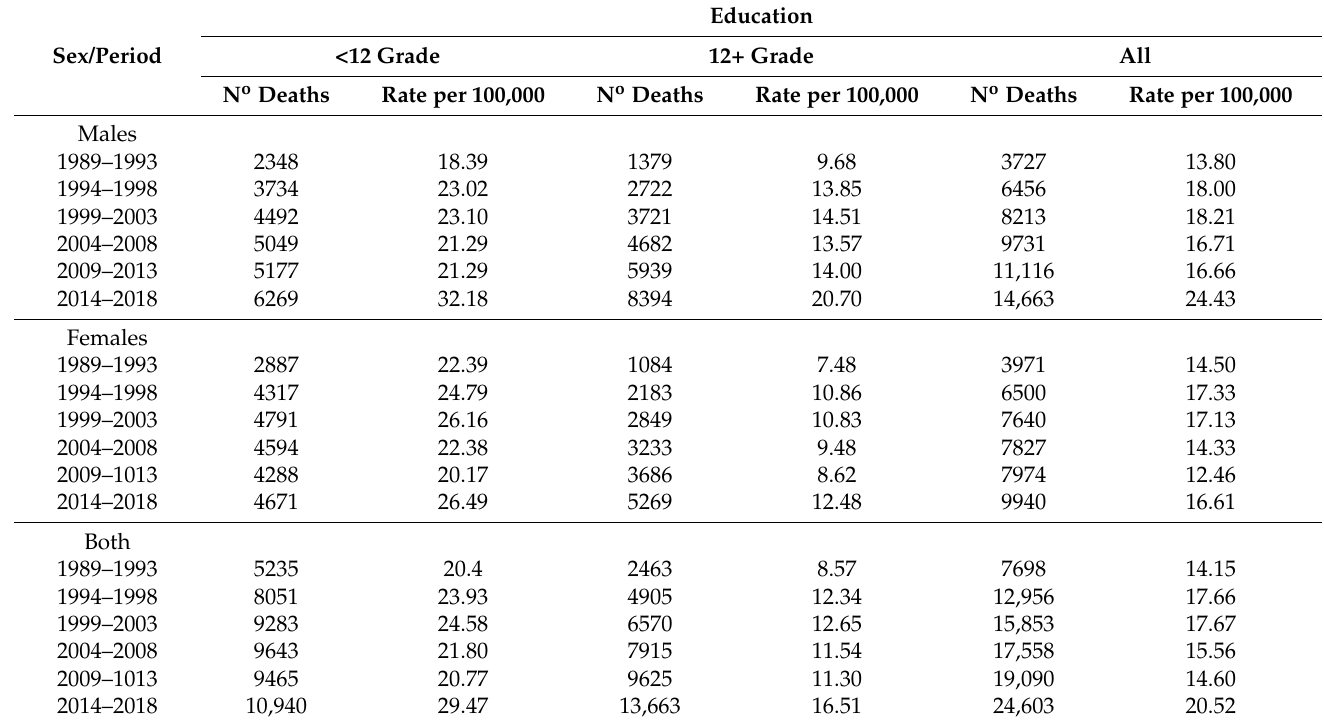
Table 1. Number and crude mortality rates due to diabetes among Hispanics in the USA from 1989 to 2018.